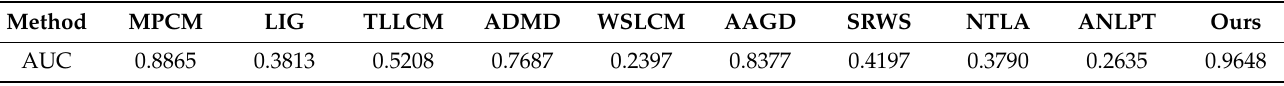
Table 8. AUC of di ff erent methods when the SNR is 1 dB. Table 8. AUC of different methods when the SNR is 1 dB.